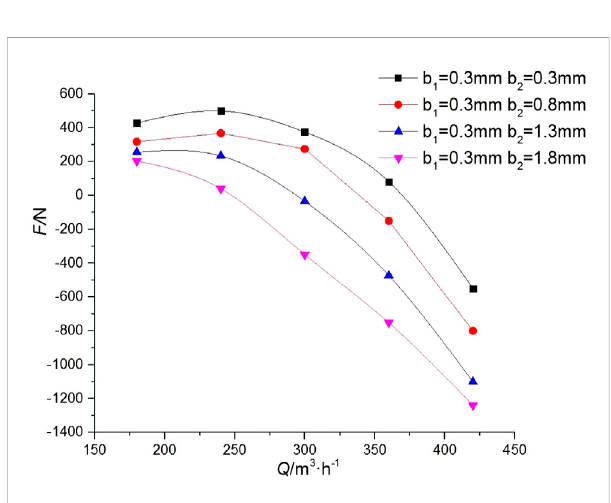
FIGURE 13 Radial force change of the CMP under different back wear-ring clearances.